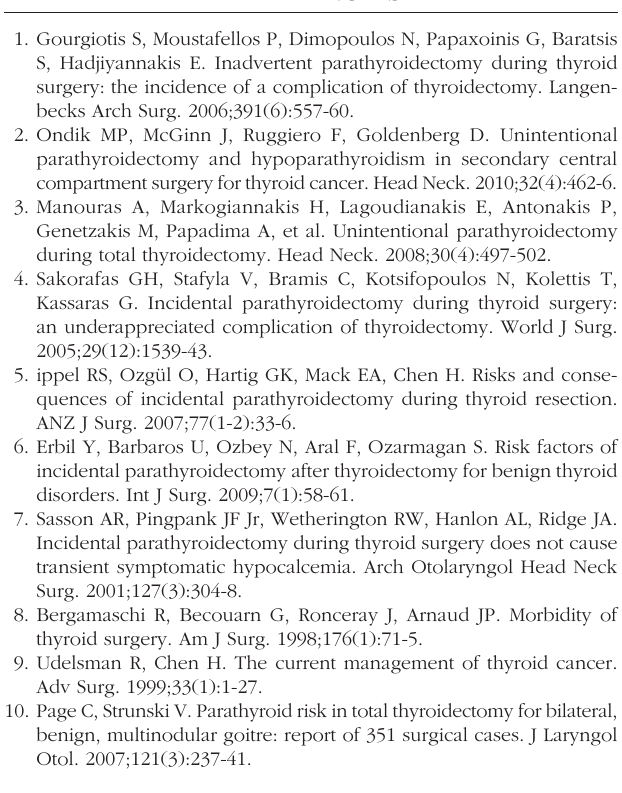
Tabela 4. Incidência de paratireoidectomia acidental na literatura. Autores, ano